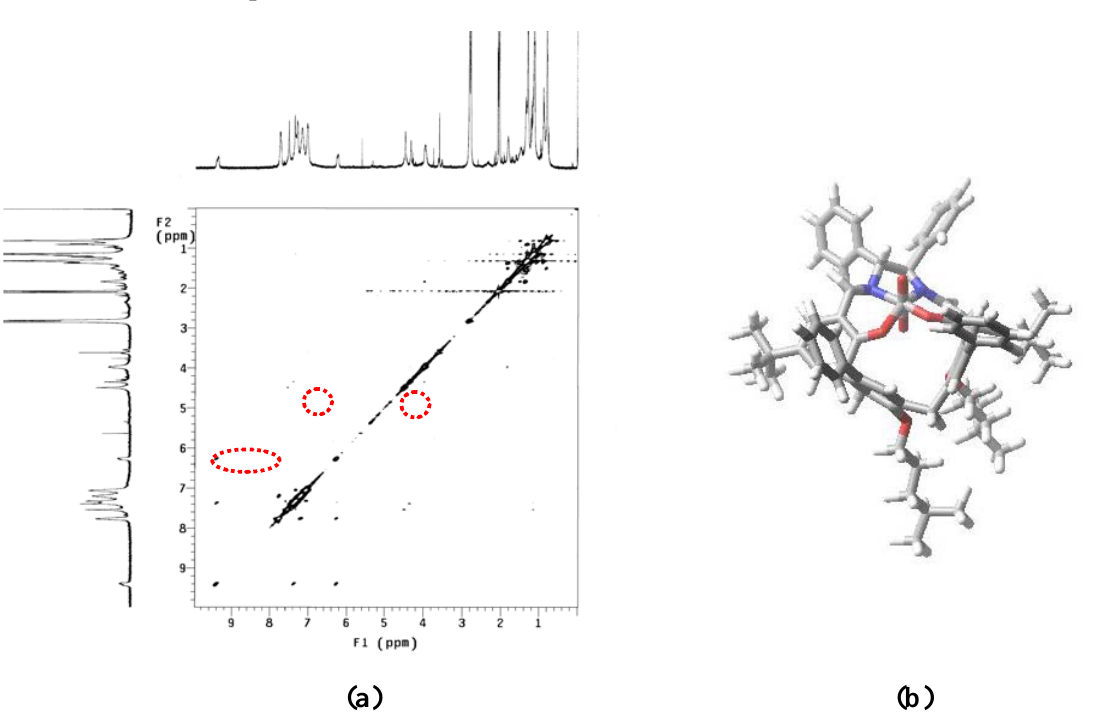
Figure 2. (a ) 1 H-NMR (500 MHz, (CD structure of complex 6-UO